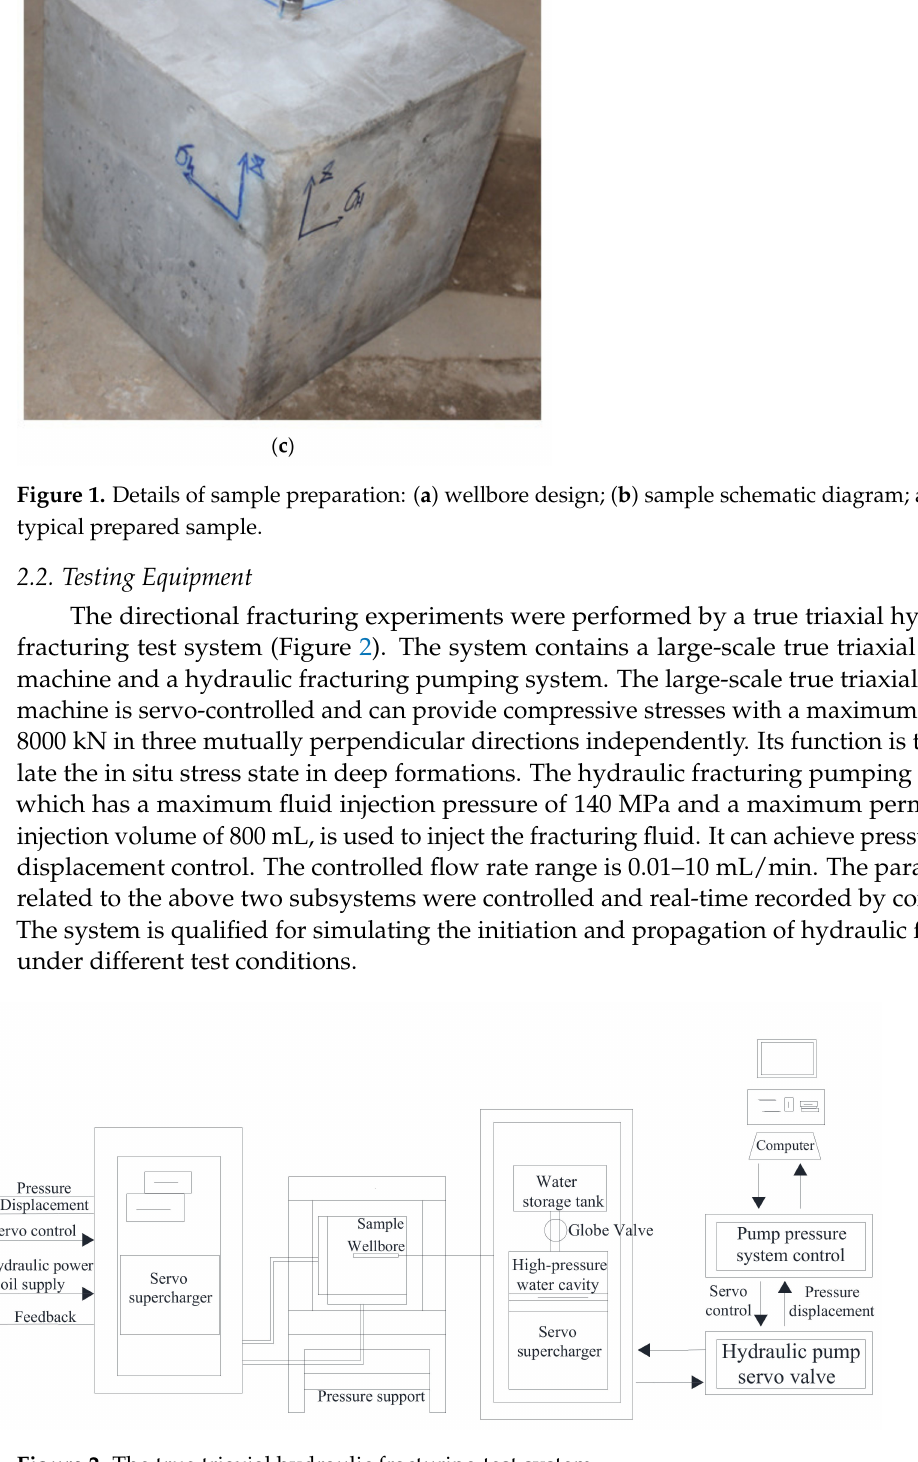
Figure 2. The true triaxial hydraulic fracturing test